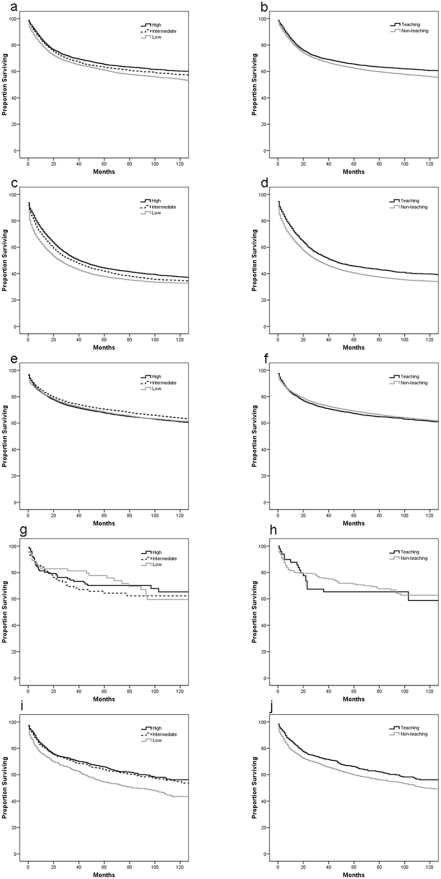
Kaplan-Meier survival curves comparing cumulative survival at teaching facilities (TF) and non-teaching facilities (NTF) for (a) cervical cancer, (b) ovarian cancer, (c) endometrial cancer, (d) uterine sarcoma, and (e) vulvar cancer and at high-volume centers (HVC), intermediate-volume centers (IVC), and low-volume centers (LVC) for (f) cervical cancer, (g) ovarian cancer, (h) endometrial cancer, (i) uterine sarcoma, and (j) vulvar cancer.